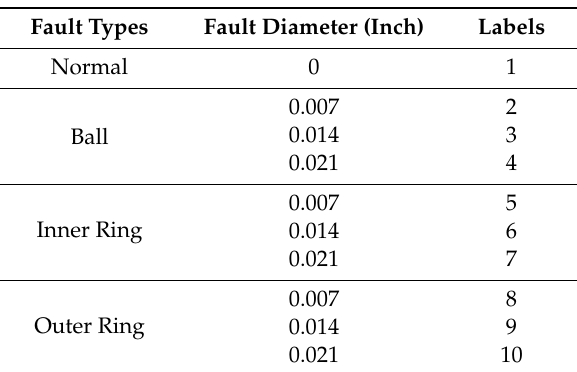
Table 1. Datasets for the ball-bearing